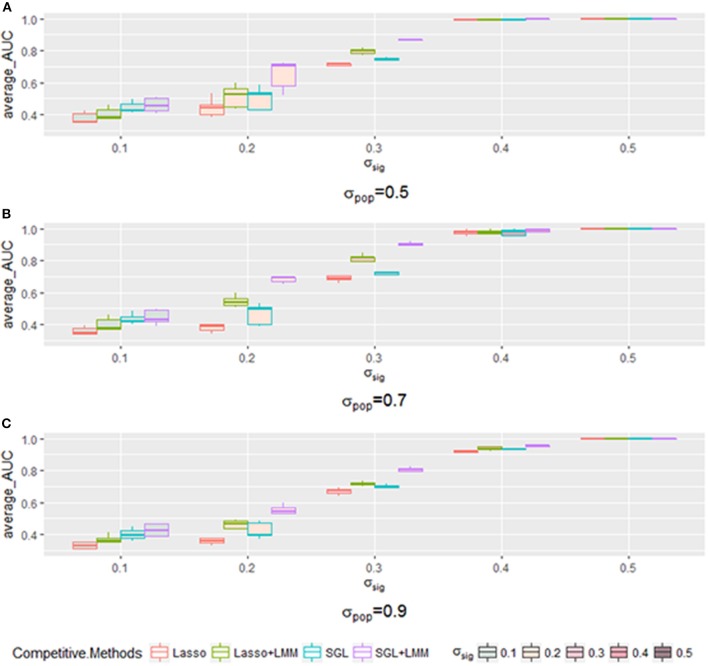
The boxplot of a sample of five points for each method with a specific when varying the σpop. Each method has a different color frame, and each that is filled with a different color is shown in the legend. (A) for σpop = 0.5, (B) for σpop = 0.7, and (C) for σpop = 0.9.